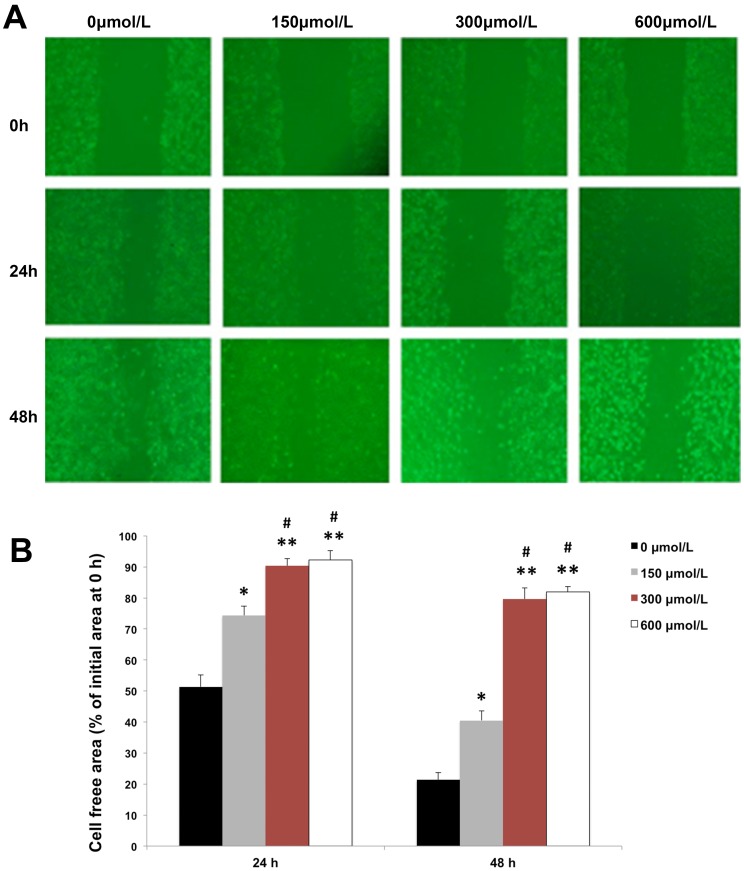
Artemether inhibited the migration of U87 cells.The effects of artemether on the migration of U87 cells were assessed by wound healing assay. (A) U87 cells were treated with artemether at various concentrations of 0, 150, 300 and 600 µmol/L for 48 h. (B) Statistical analysis of migrating cell numbers. Migration of U87 cells was inhibited with the increased concentration of artemether. The healing over scratch was inhibited significantly after 24 and 48 h from 150 µmol/L (P<0.05). The concentrations of 300 and 600 µmol/L displayed greater inhibitory effects (P<0.01). However, there was no significant difference between 300 and 600 µmol/L groups. (X200). n = 4. *P<0.05, **P<0.01 (compared with 0 µmol/L group), #
P<0.05 (compared with 150 µmol/L group).